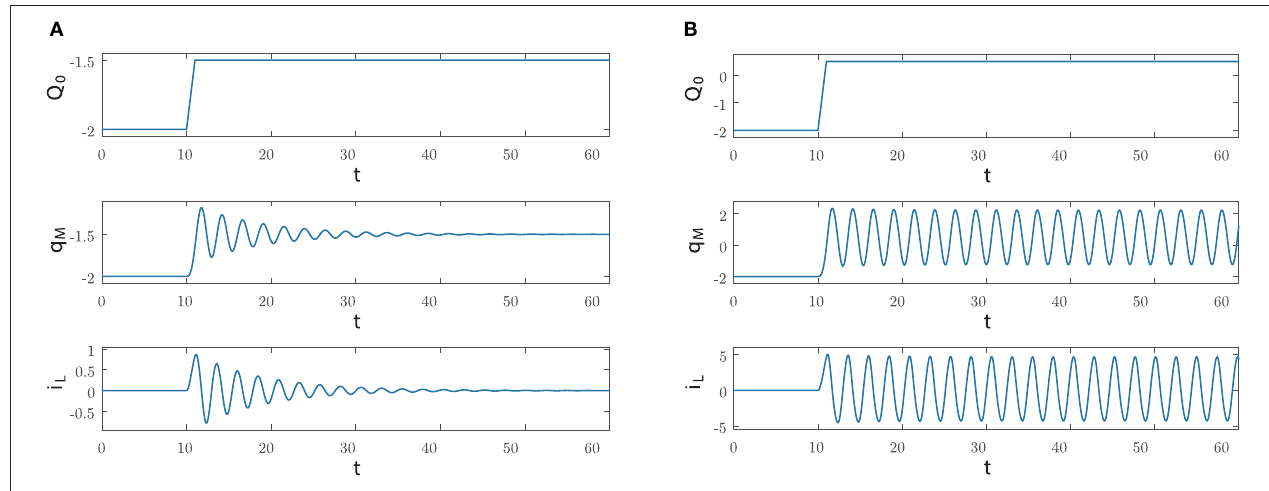
FIGURE 9 | Dynamics generated by applying at t i Equation (30) and the initial conditions are q M (0) Q 0 1.5 and to the equilibrium point ( = − cycle belonging to the manifold M (0.5).